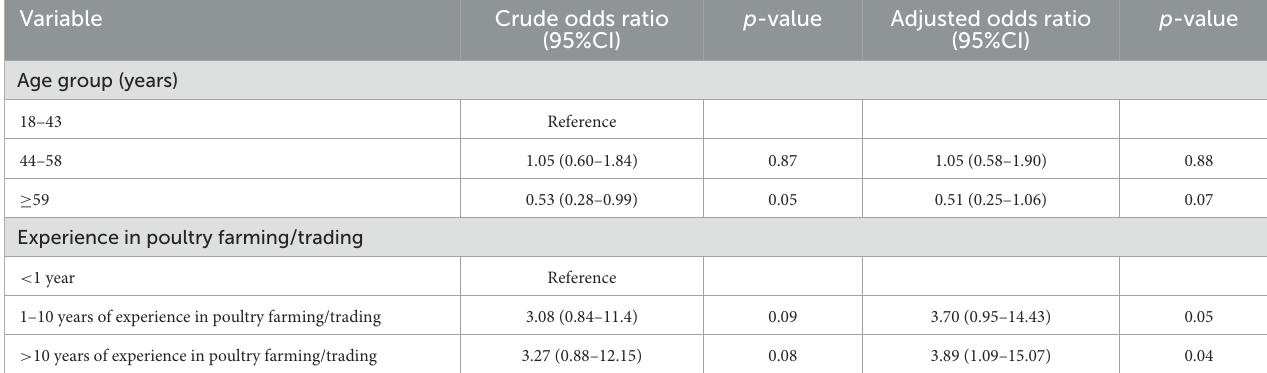
TABLE 3 Multivariate logistic regression analysis of factors associated with risk perception scores on avian influenza among live-poultry traders and farmers along border areas in three provinces of